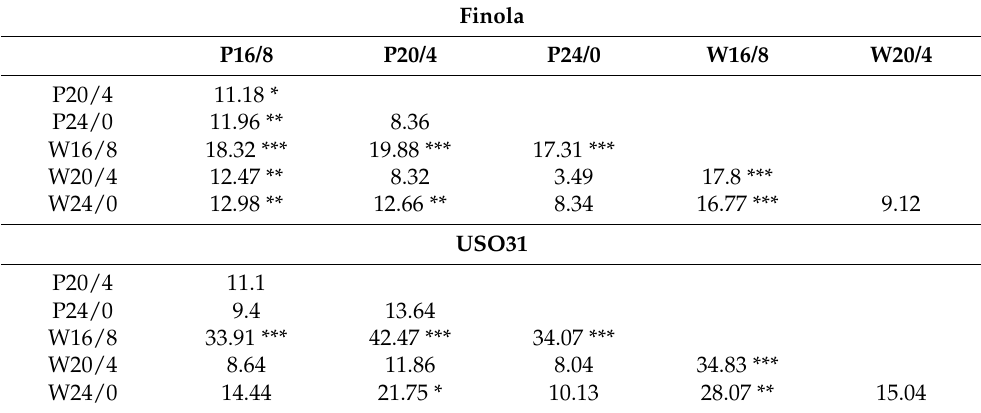
Table 2. Mahalanobis distances in Finola and USO31 cultivars exposed to 16/8, 20/4, and 24/0 photoperiods and grown under white (W) and purple (P) light. * represents significance at p < 0.05, ** represents significance at p < 0.01, *** represents significance at p < 0.001, based on 1000